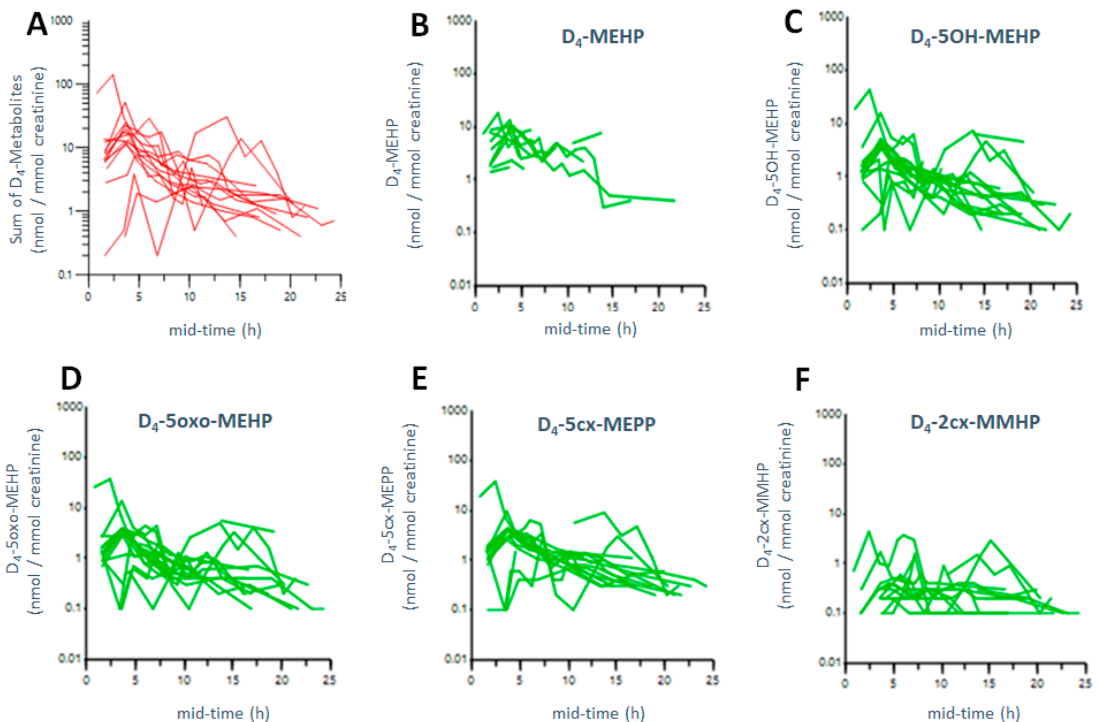
Figure 3. Excretion kinetics of D 4 -DEHP metabolites. Urinary metabolites from 16 participants over mid-time (mid time point of collection interval) after combined inhalation and dermal exposure of D 4 -DEHP: sum of all five analysed metabolites ( A ), and D 4 -MEHP ( B ), D 4 -5OH-MEHP ( C ), D 4 -5oxo-MEHP ( D ), D 4 -5cx-MEPP (E), D 4 -2cx-MMHP ( F ), respectively. The y-axis is presented on a logarithmic scale, and time points are given in mid-time (mid time point of collection interval).